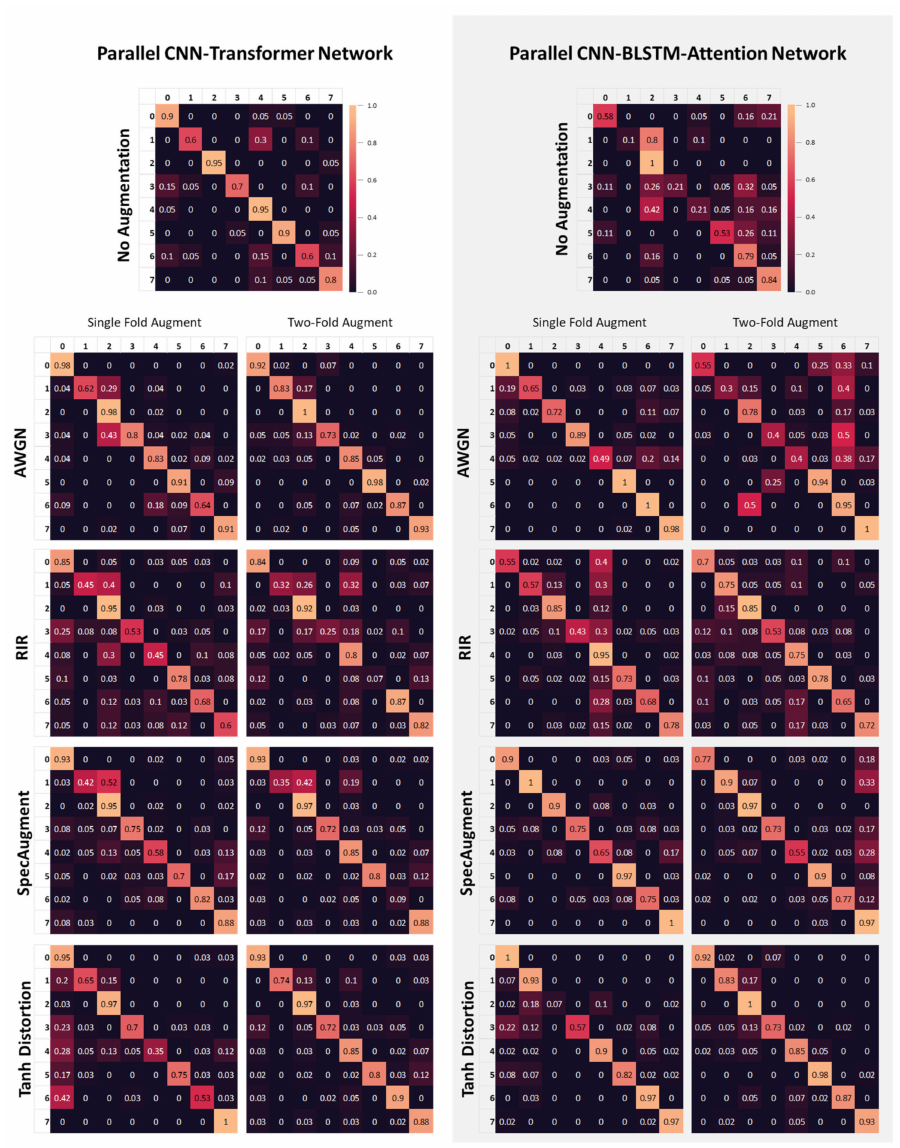
Figure 6. Normalized Confusion Matrix for the Parallel CNN-Based